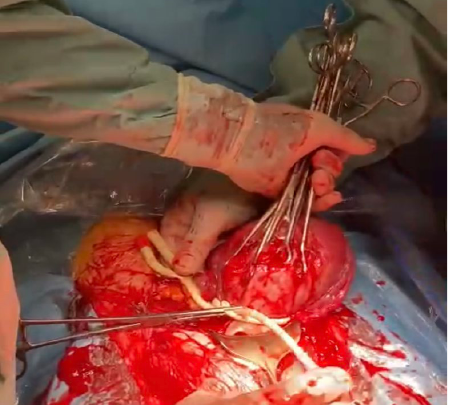
Figure 10. Placement of a Foley catheter as a tourniquet to prevent hemorrhage.